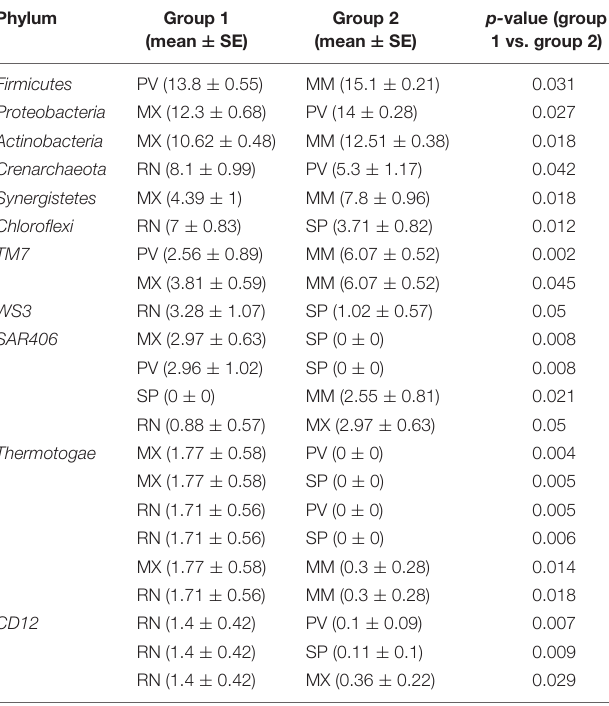
TABLE 1 | The significantly different ( p < 0.05) gut microbial relative abundance at the phylum level among five pheasant lineages. Phylum Group 1 Group 2 p- value (group (mean ± SE) (mean ± SE) 1 vs. group 2)